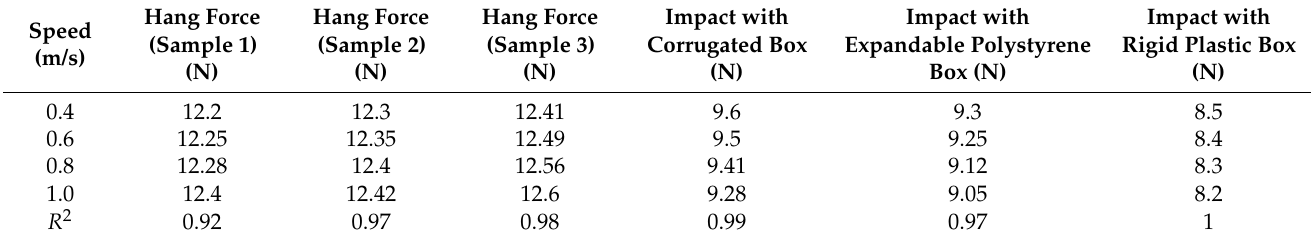
Table 2. Hang and impact force under different speed intensities.